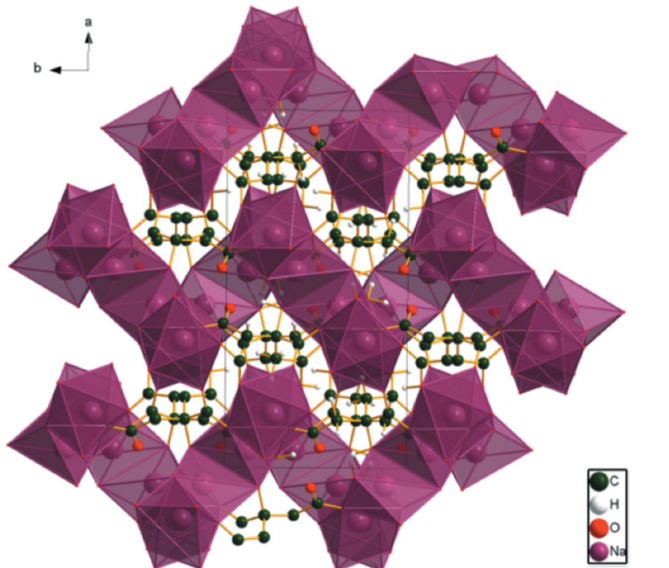
Figure 5 The crystal structure of (I) viewed down the c axis.